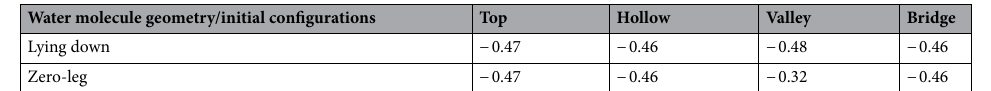
Table 2. Water absorption energies (eV) for lying down and one-leg geometries for different initial attaching positions, including top, hollow, valley, and bridge 40 . a 3 × 3 SND has been chosen here.